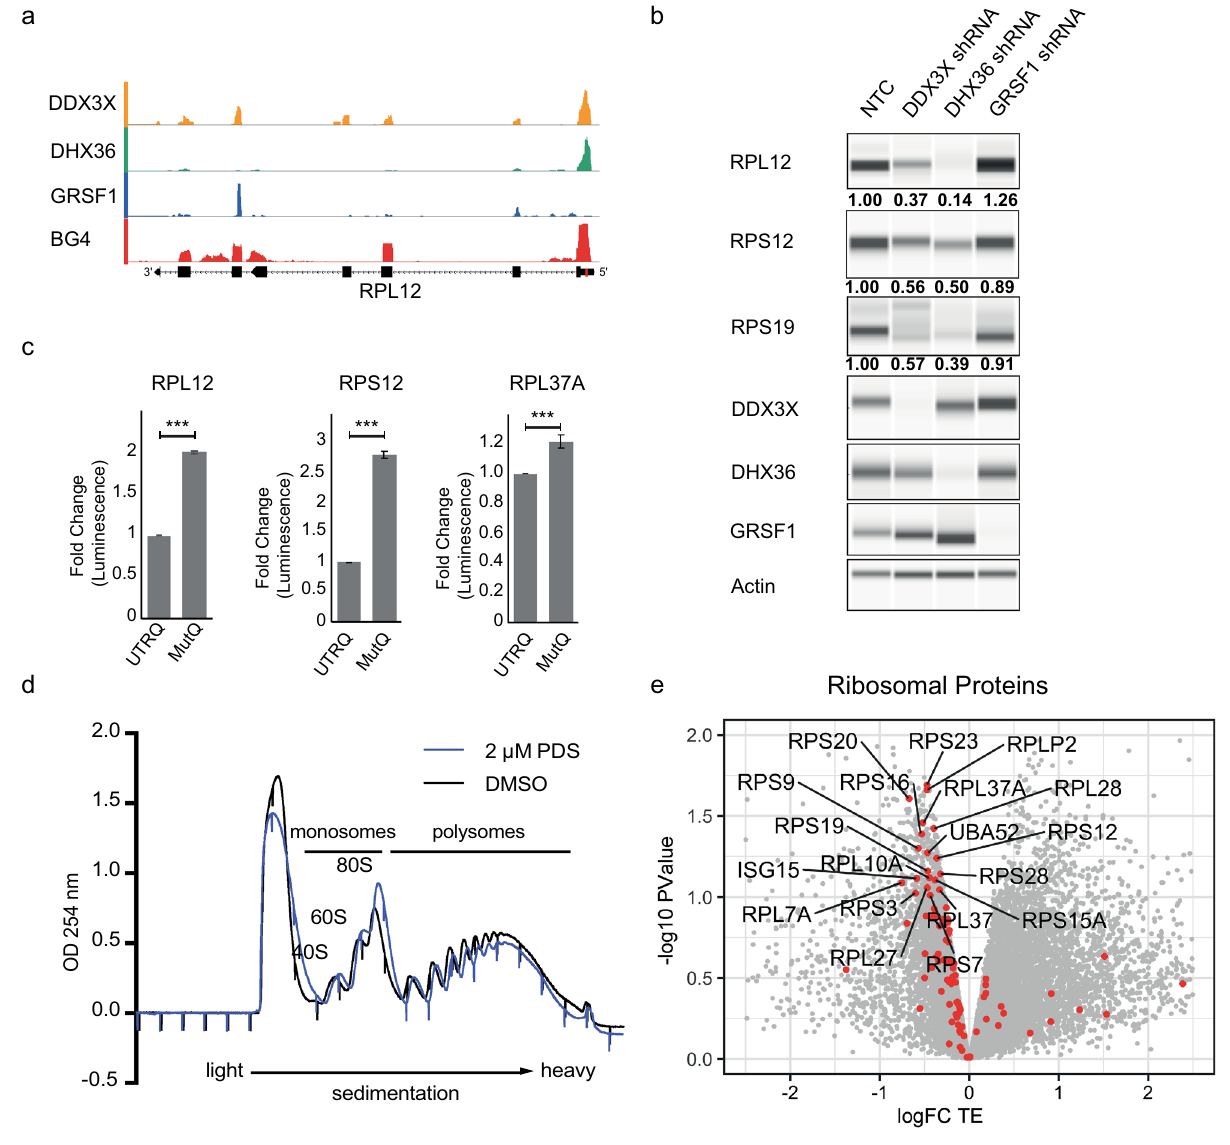
Figure 3. RNA G4s in ribosomal protein mRNA regulate translation. ( a ) Example snapshots demonstrating BG4 peaks in 5 ′ UTRs and overlapping iCLAE peaks. BG4 track depict logFC of BG4 IP vs input and iCLAE track depict counts per million. ( b ) Western blot analysis of ribosomal protein levels following shRNA mediated depletion of DDX3X, DHX36 and GRSF1. Actin serves as loading control. Number below each lane represents fold change in ribosomal protein levels compared to non-targeting control (NTC) when normalised to actin. ( c ) Fold change in luminescence comparing in vitro translation of luciferase gene from wild-type ribosomal protein UTRs containing G4 (UTRQ) to mutant UTRs with G4 disruption (MutQ). ( d ) UV absorption at 254 nM following sucrose fractionation for polysome profiling of cells treated with DMSO (black) and 2 μM PDS (blue) for 45 min. Monosomal and polysomal fractions are highlighted. ( e ) Fold change in translation efficiency (logFC TE) of each transcript plotted against the significance (− log10 p-value) over three independent biological replicates. All ribosomal protein mRNAs are highlighted in red and those with significant changes (FDR < 0.1) are labelled with the corresponding protein